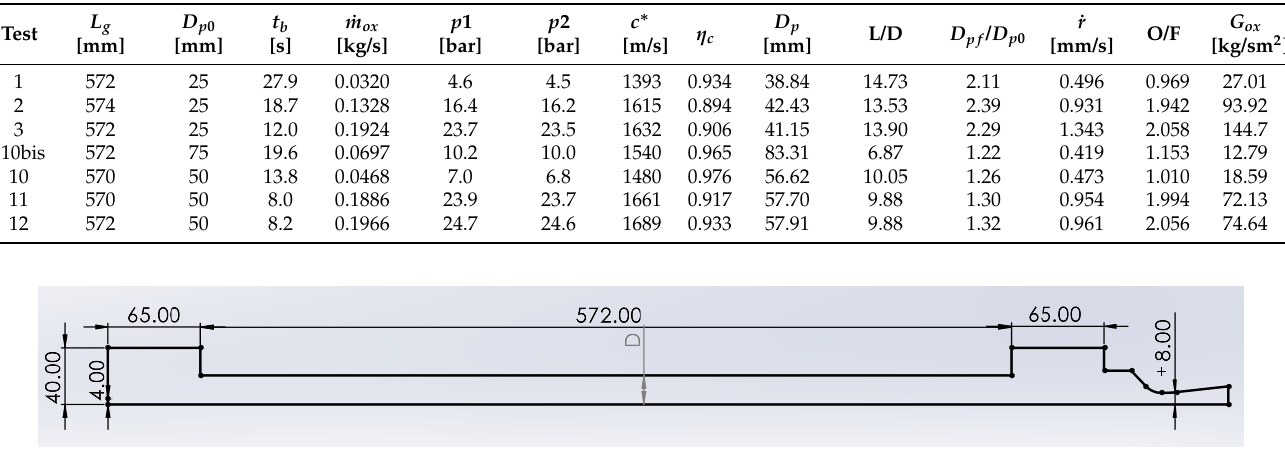
Table 2. Experimental data from literature for a lab-scale GOX-HTPB motor [64].